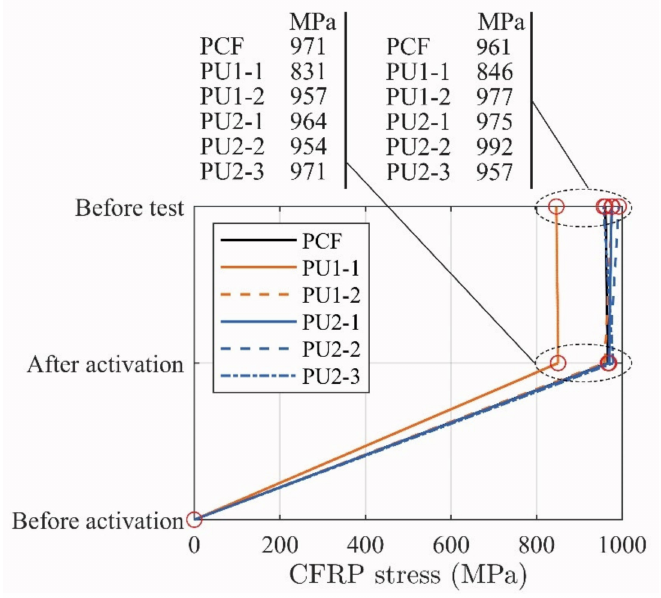
Figure 8. Evolution of the activation values until testing.